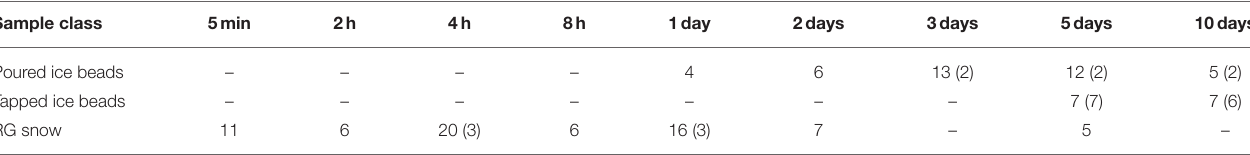
Number in parentheses is the number of samples with CT